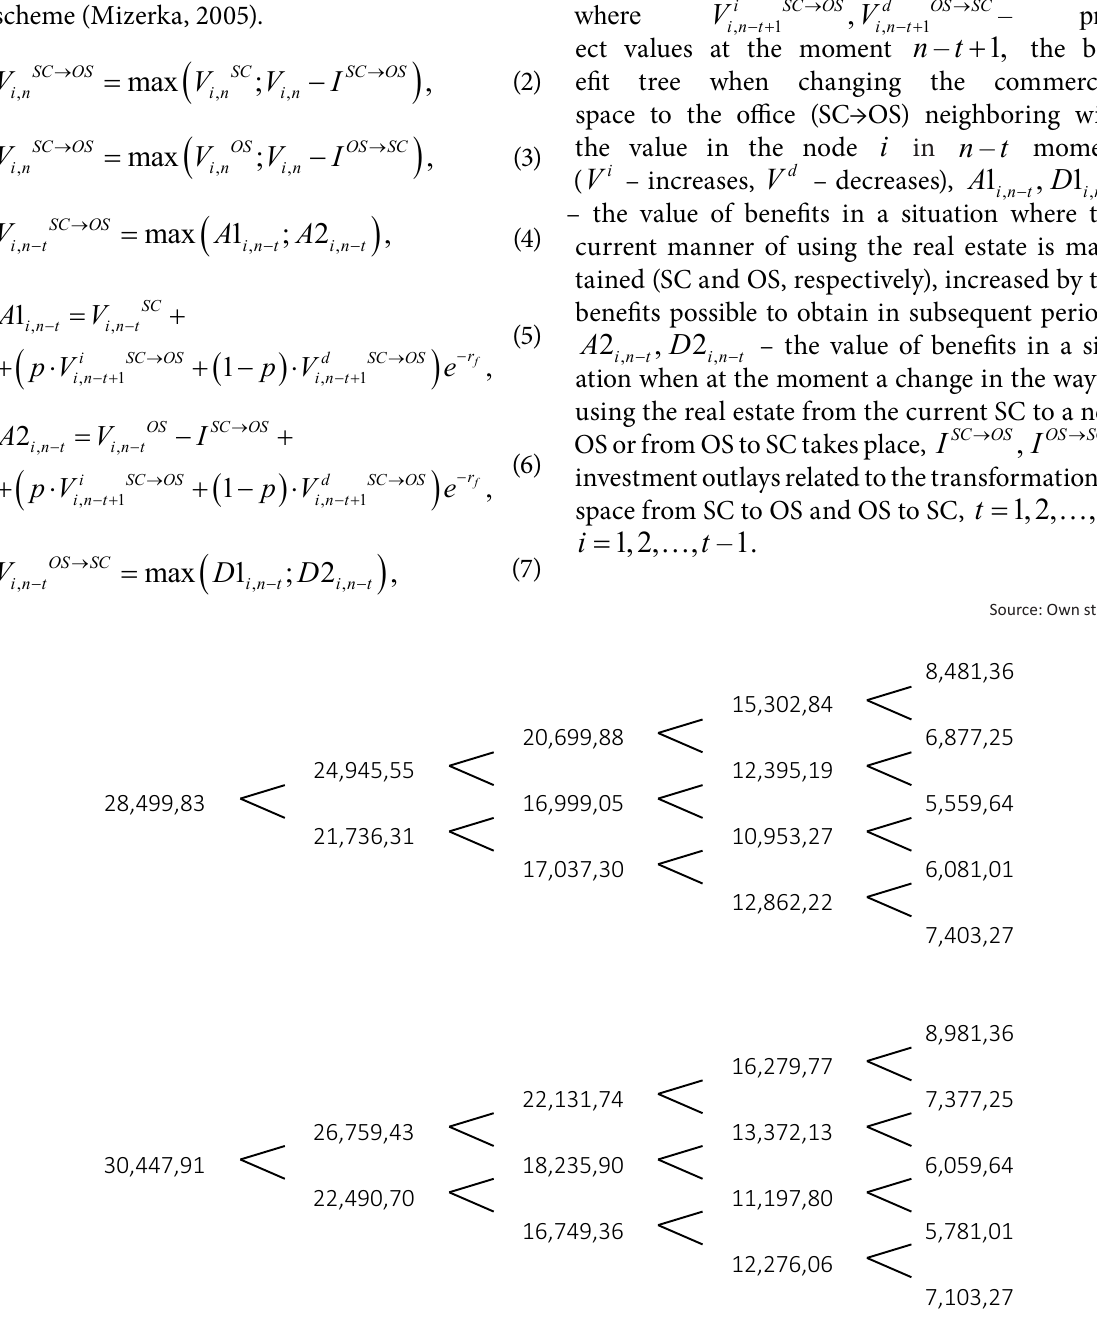
Figure 2. Benefits of changing the SC to OS (top) and OS to SC